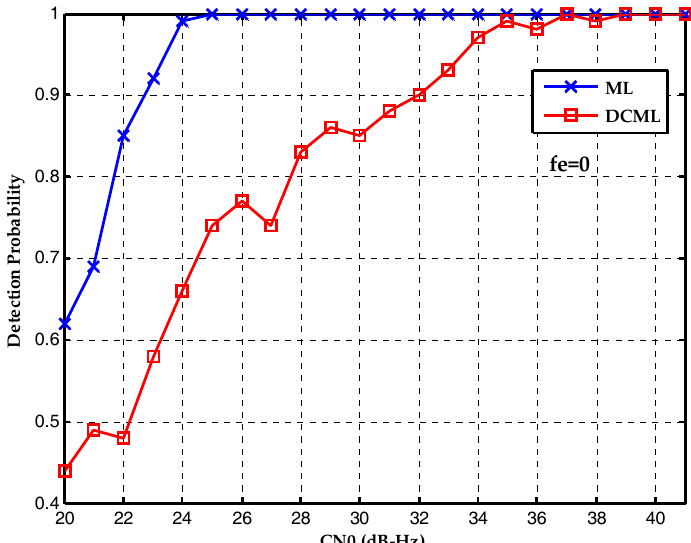
Figure 11. Detection probabilities of ML and DCML bit synchronization algorithms under the CN0s of 20~40 dB-Hz with a frequency deviation of 0 Hz.